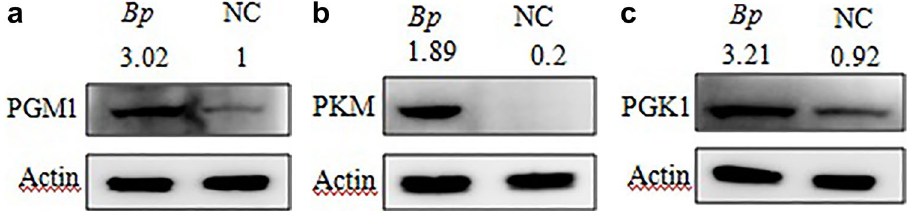
Figure 3. Changes in the expression of enzymes related to glucose metabolism on the Western Blot. ( A ) PGM1 increased 3.02-fold in BP group. ( B ) PKM increased 9.45-fold in BP group. ( C ) PGK1 increase 3.50-fold in BP